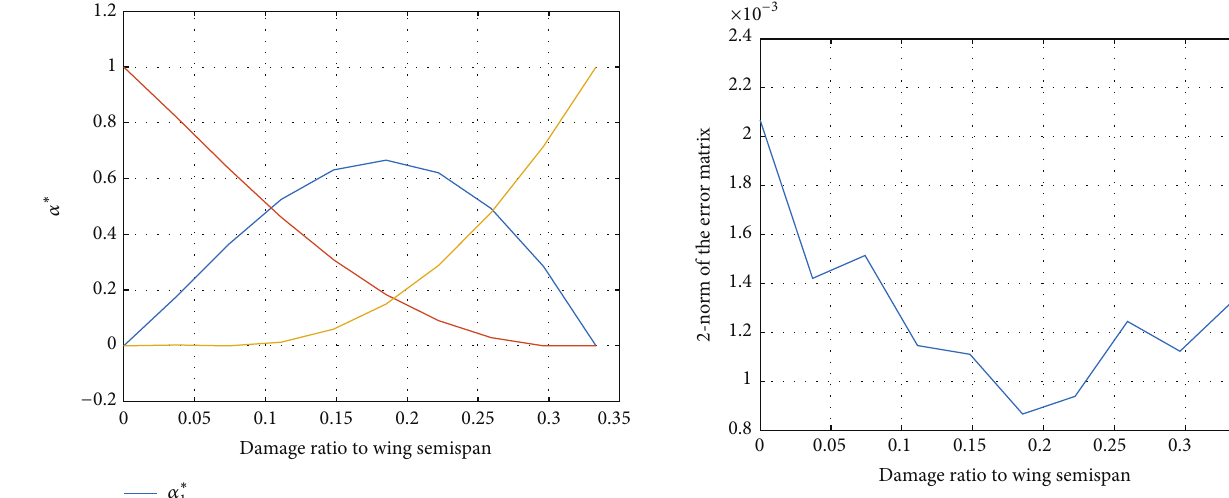
Figure 2: The accuracy of processed